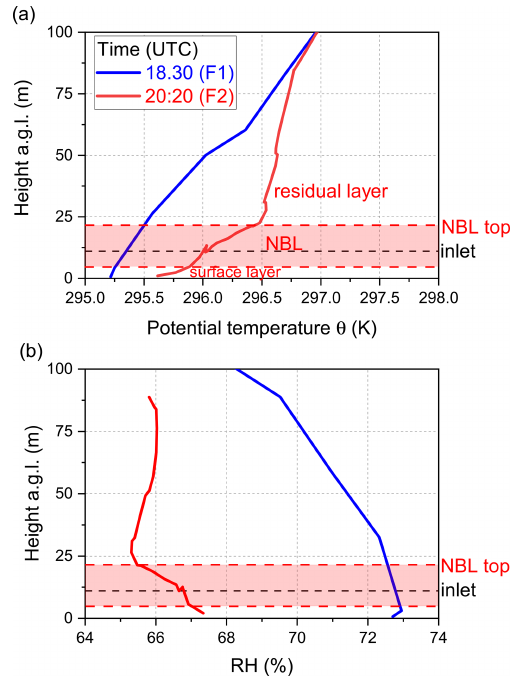
Figure 4. Vertical profiles of potential temperature (a) and relative humidity (b) at the summit of the Kleiner Feldberg at 18:30UTC (blue) and 20:20UTC (red). The nocturnal boundary layer (NBL) at 20:20UTC is shaded red. The inlet height is indicated by a black dashed